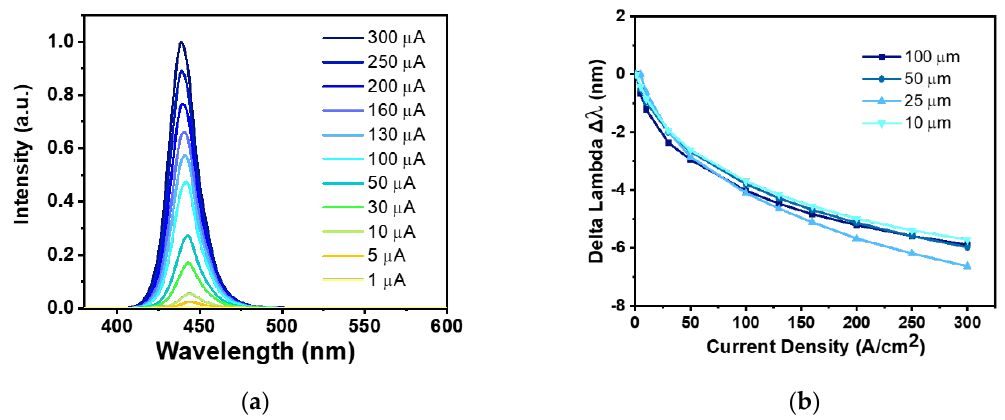
Figure 5. ( a ) EL spectra of a 10 × 10 μm 2 blue micro-LED at various forward currents; ( b ) EL shift as a function of current density for different blue micro-LED sizes. Table 2. Variation in peak wavelength and FWHM of different sizes of micro-LEDs form 1 A/cm 2 to 300 A/cm 2 .